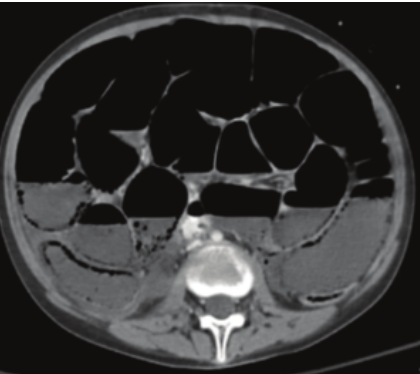
Figure 1: Computed tomography showing air in the intestinal